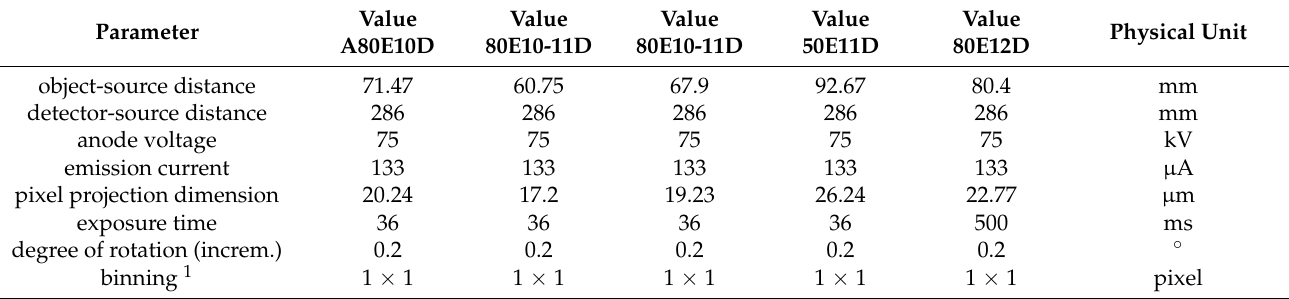
Table A4. Values of set parameters on SkyScan 1275.